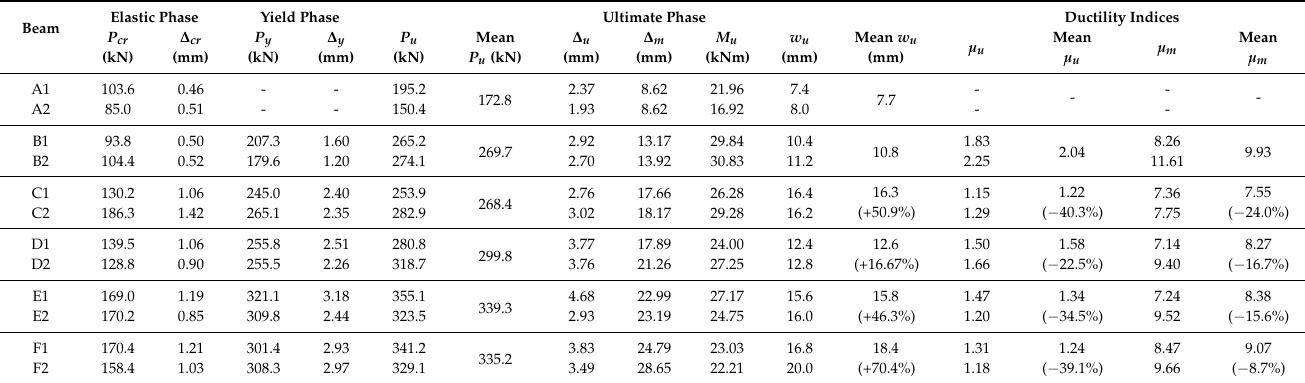
Table 7. Summary of the four-point testing of UHPC